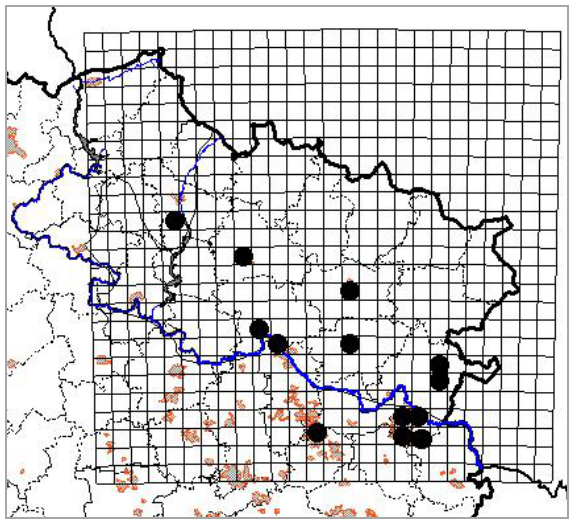
Fig. 20. The map of the distribution of Galinsoga parviflora Cav. in the Starobilsk grass-meadow steppe